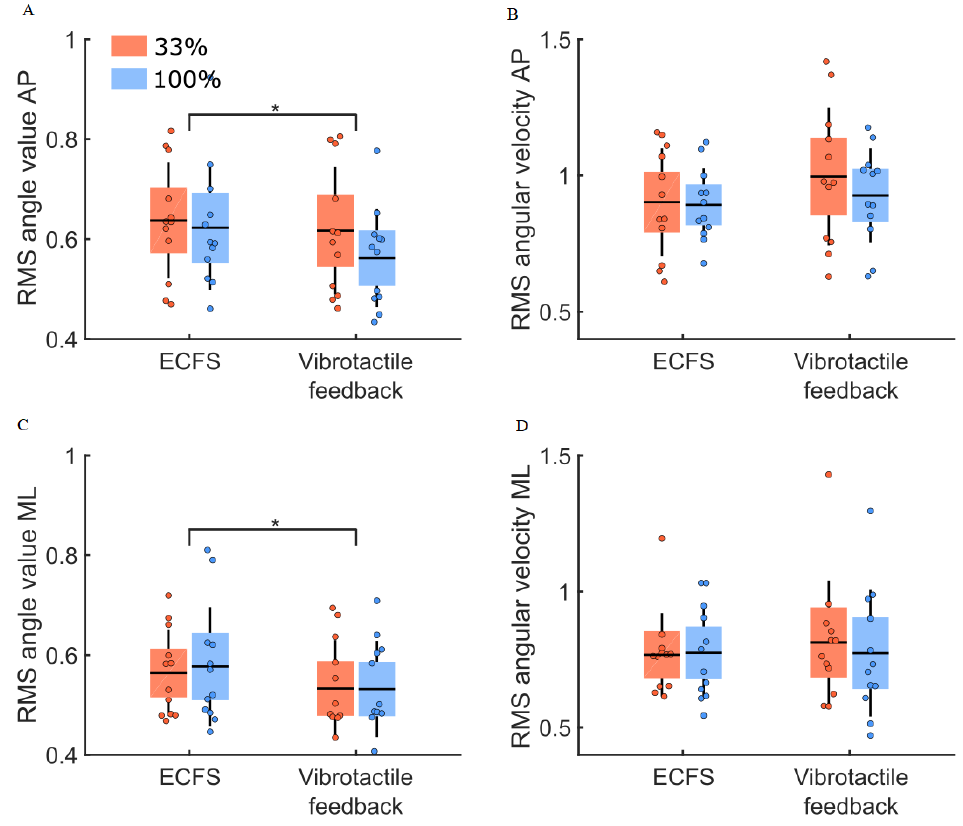
Figure 7. RMS values for body sway angle and angular velocity for both groups (33% and 100% feedback groups, red and blue boxes, respectively) in the control (ECFS) and the vibrotactile feed- back conditions. Panels ( A , C ), RMS values of the body sway angle along the AP and ML axes. Panel ( B , D ), RMS values of the body sway angular velocity along the AP and ML axes. The dots represent the mean results for each participant, horizontal lines depict the group’s means, boxes represent the group’s standard error of the mean , and vertical lines, one standard deviation. The asterisks (*) in- dicate a significant main effect of condition. The units for the RMS values of the body sway angle and angular velocity are (°) and (°/s). Spearman’s correlation between the improvement in bal ance control with vibrotac- tile feedback and balance control in the control condition (ECFS) revealed weak correla- tions for the RMS values of the body sway angle (33% feedback group: AP axe, r = −0 .07,